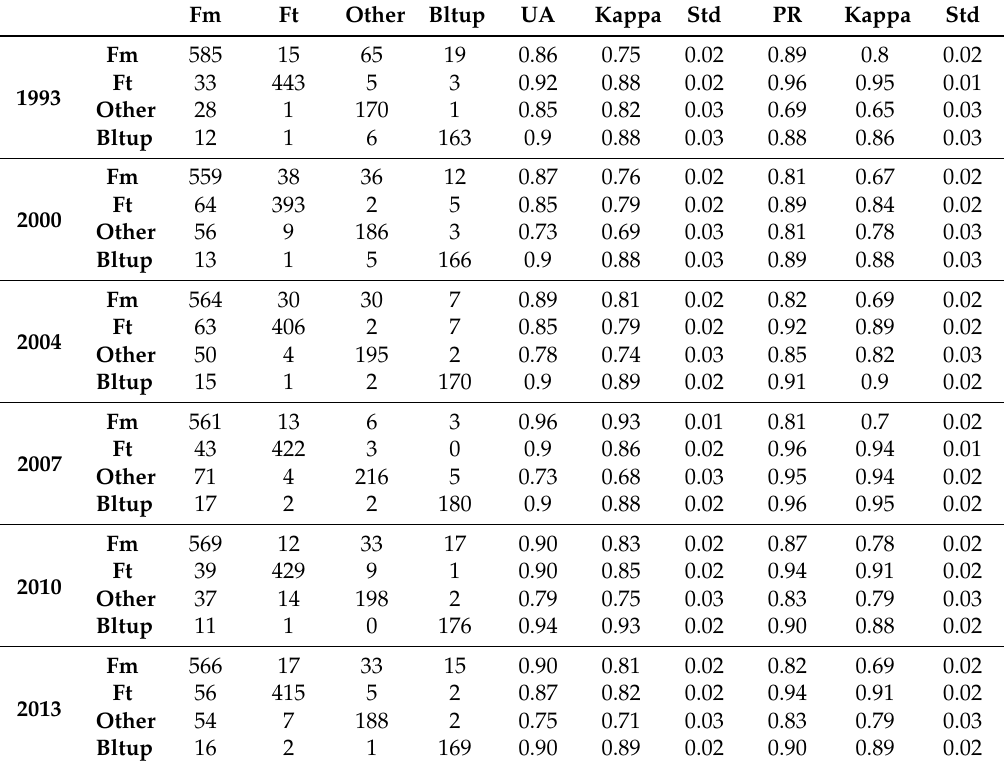
Table B3. LULCC category-based accuracy assessment for later